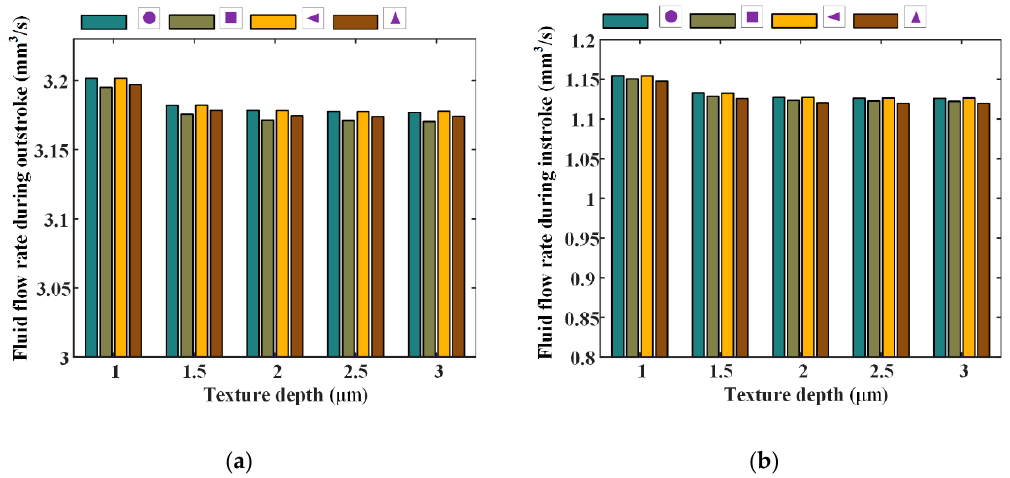
Figure 22. The relationship between wear time rate and texture depth, (a) outstroke, (b) instroke.